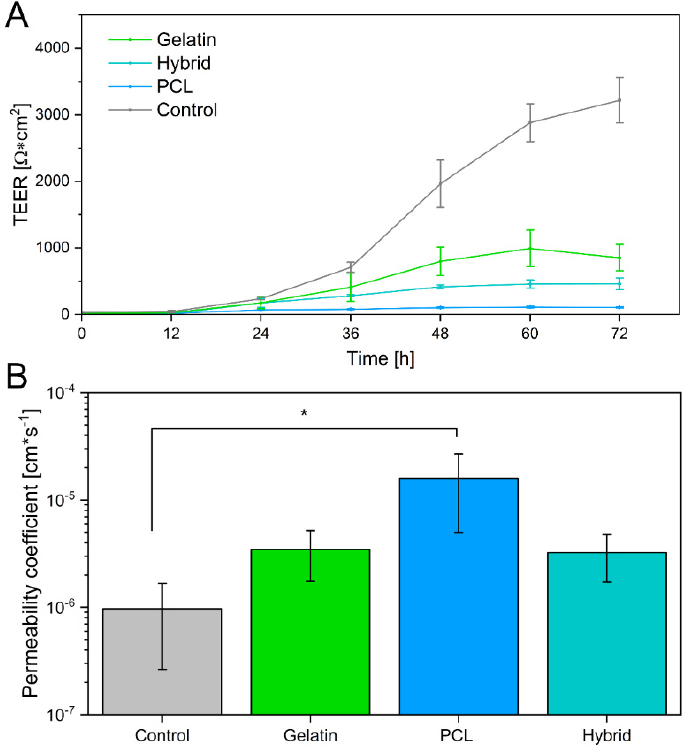
Figure 9. ( A ) Transendothelial electrical resistance of hiPS-BCECs cultivated on gelatin, hybrid, and PCL electrospun scaffolds, as well as Matrigel ® -coated Transwell ® inserts. ( B ) Permeability of sodium fluorescein across cultivated hiPS-BCECs on electrospun scaffolds. Matrigel ® -coated Transwell ® inserts were used as a control. * p < 0.05 for PCL compared to the control.